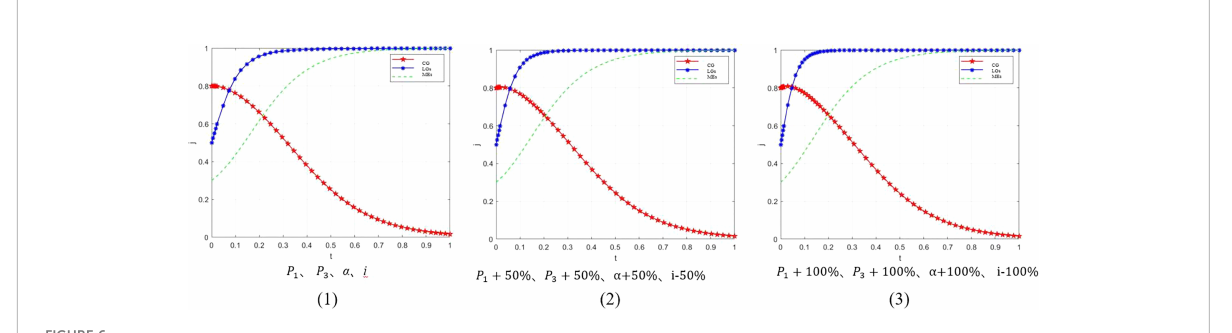
FIGURE 6 The impact of CG ’ penalties on the evolution.